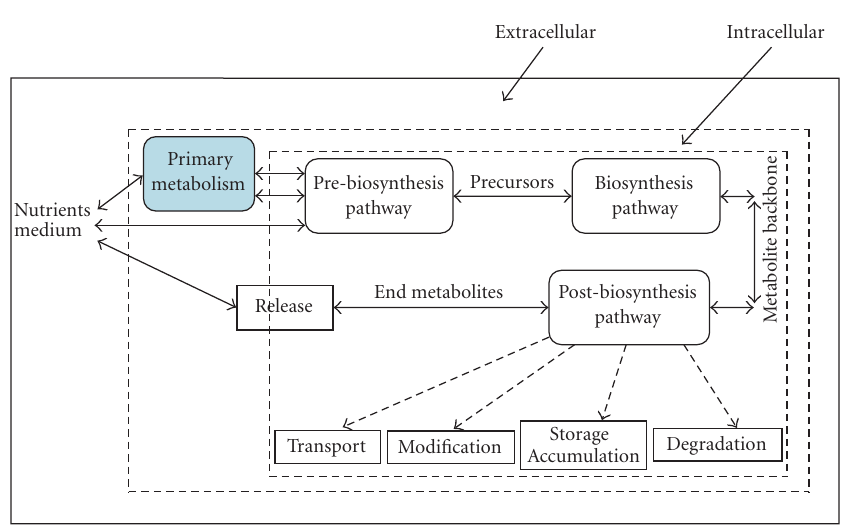
Figure 3. Pathway events involved in biosynthesis of a metabolite in plant cells: primary metabolism and secondary metabolism (pre-biosynthetic, biosynthetic, and post-biosynthetic pathways).